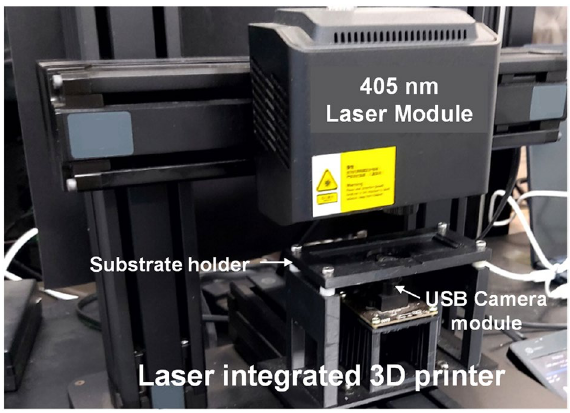
Figure 1. The laser-integrated 3D printer with a USB camera